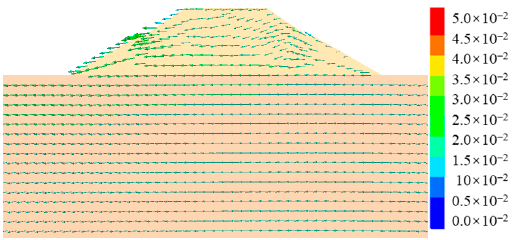
Figure 15. Displacement vectors of the fill subgrade after earthquake.